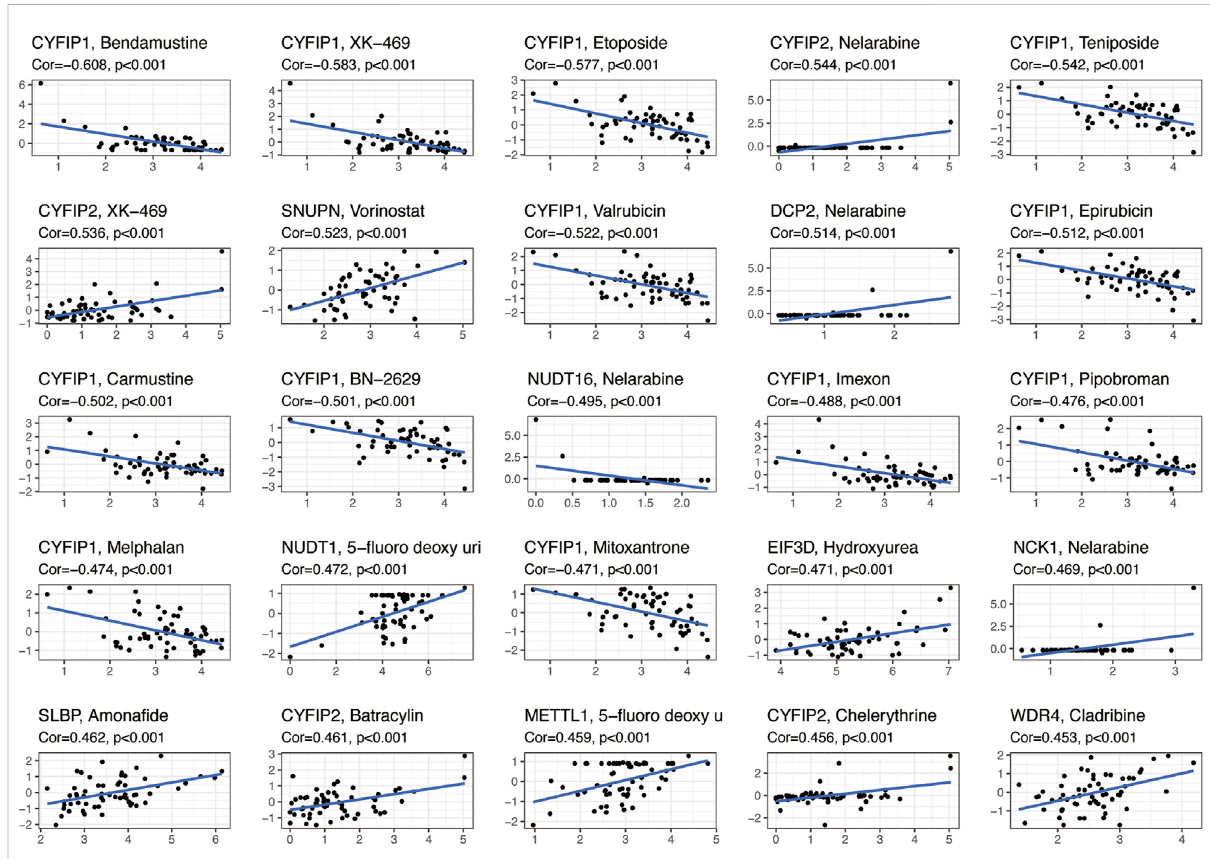
FIGURE 4 Scatterplots showing the association between the expression of m7G regulators and drug sensitivity (Z-score from CellMiner interface) using NCI-60 cell line